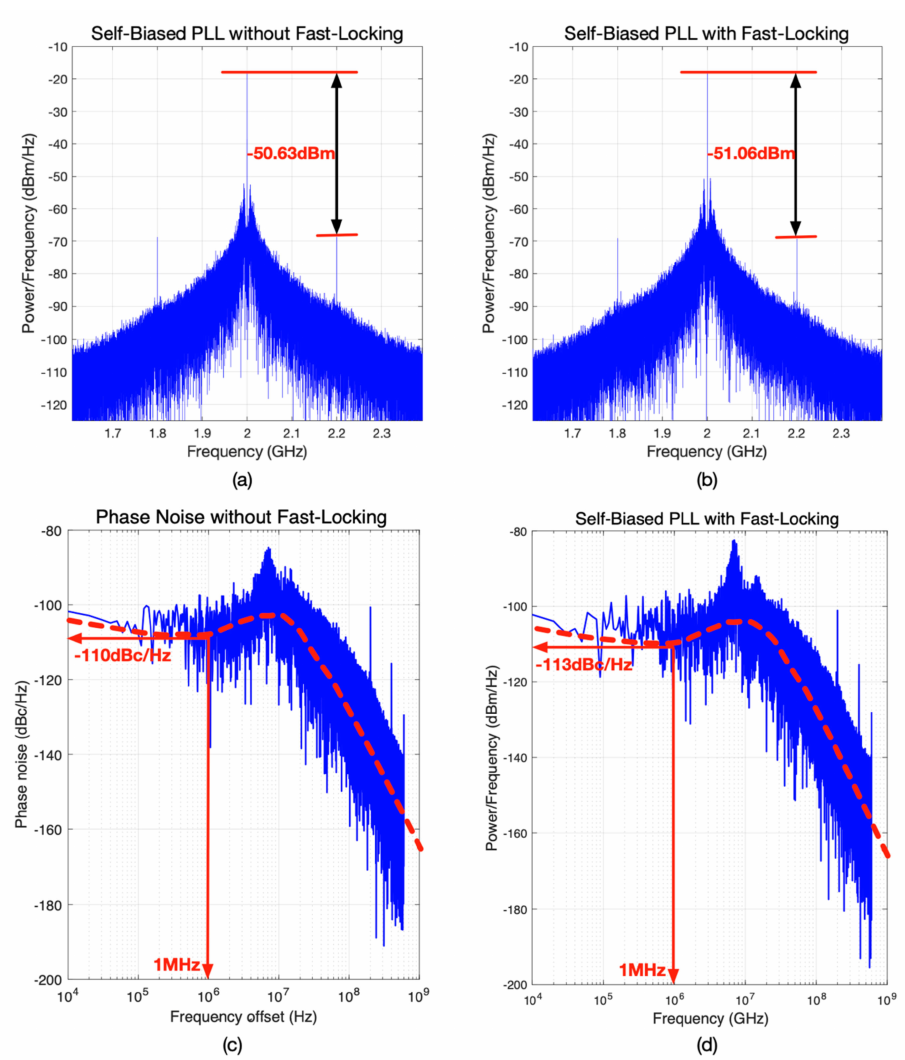
Figure 9. ( a ) Simulated reference spur of the PLL without fast-locking module, ( b ) Simulated reference spur of the PLL with fast-locking module, ( c ) l Simulated phase noise of the PLL without fast-locking module, and ( d ) Simulated phase noise of the PLL with fast-locking